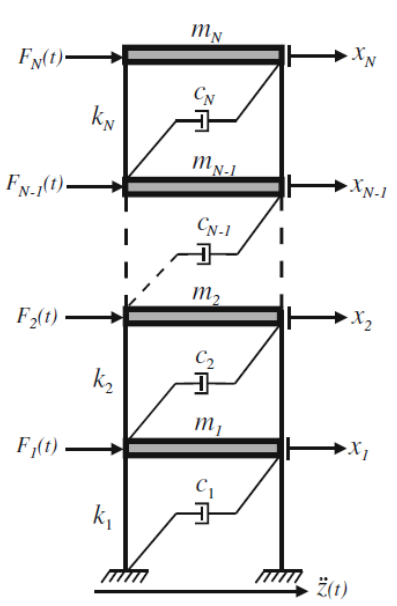
Figure 2. Model of the main system to be passively